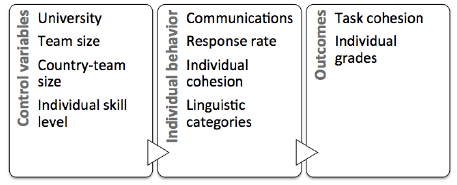
Figure 1. Control, individual behavior and outcome variables at individual level.